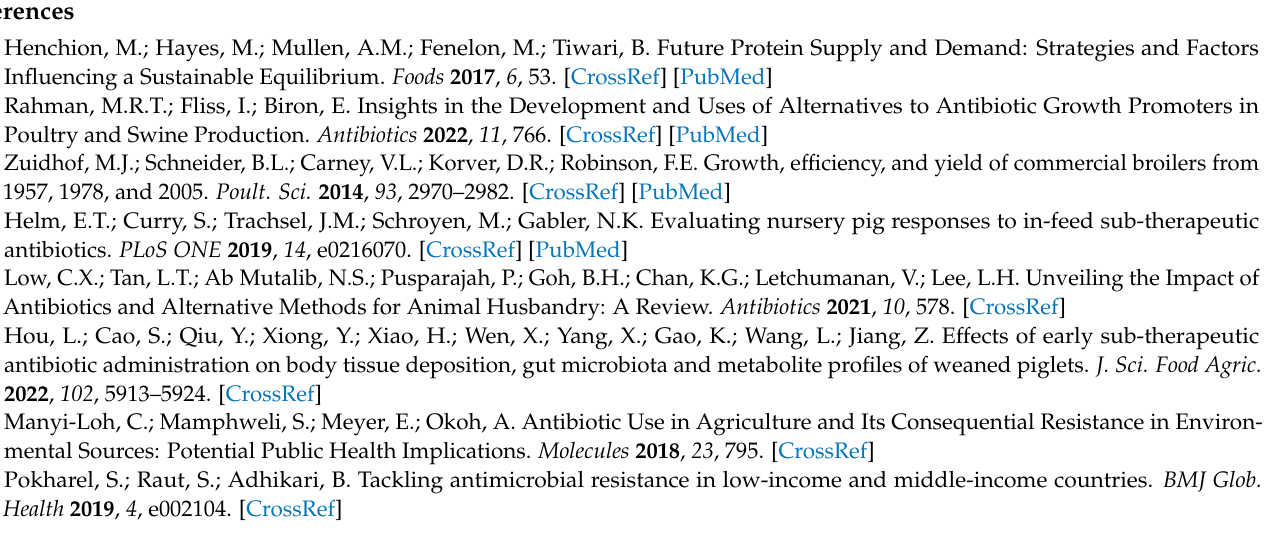
Table S2: Growth performance throughout the experimental phases. Table S3: Serum GH and IGF-I. Table S4: DEGs of the liver. Table S5: DEGs of the skeletal muscle. Table S6: Liver GO enrichment analysis. Table S7: Liver KEGG enrichment analysis. Table S8: Skeletal muscle GO enrichment analysis. Table S9: Skeletal muscle KEGG enrichment